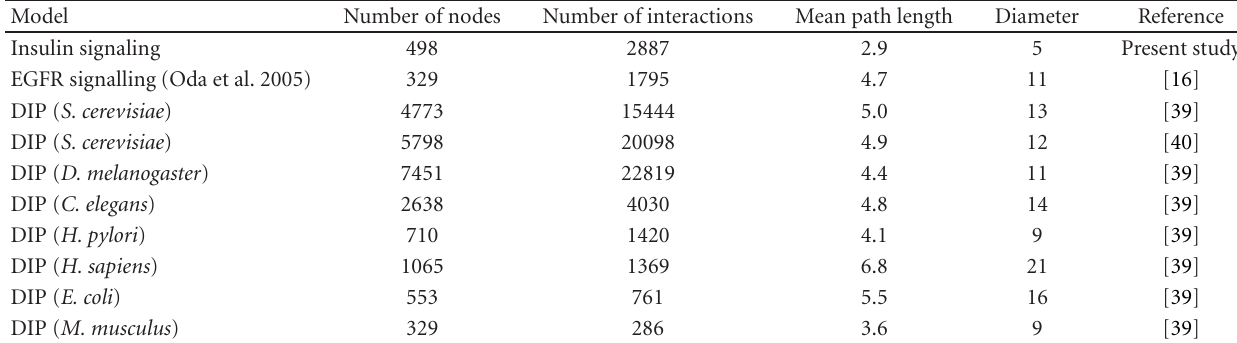
Table 4: Graph properties of protein interaction